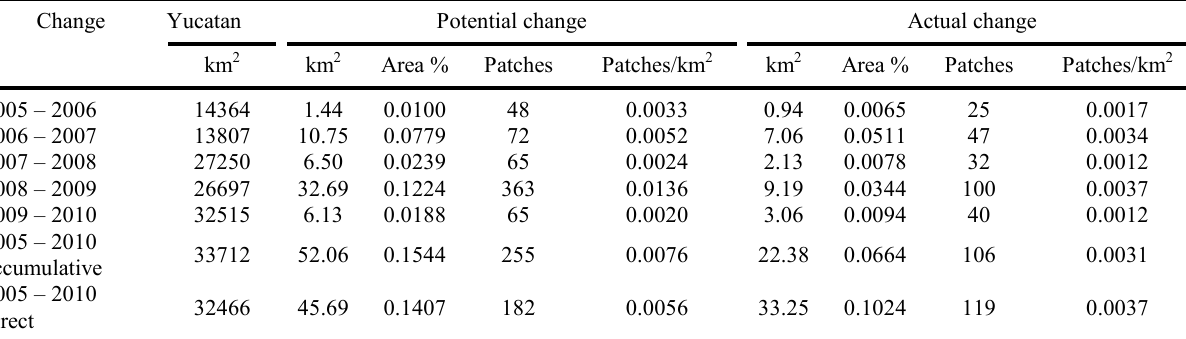
Table 4. Area and patches for potential and actual change of MODIS data for Yucatan.